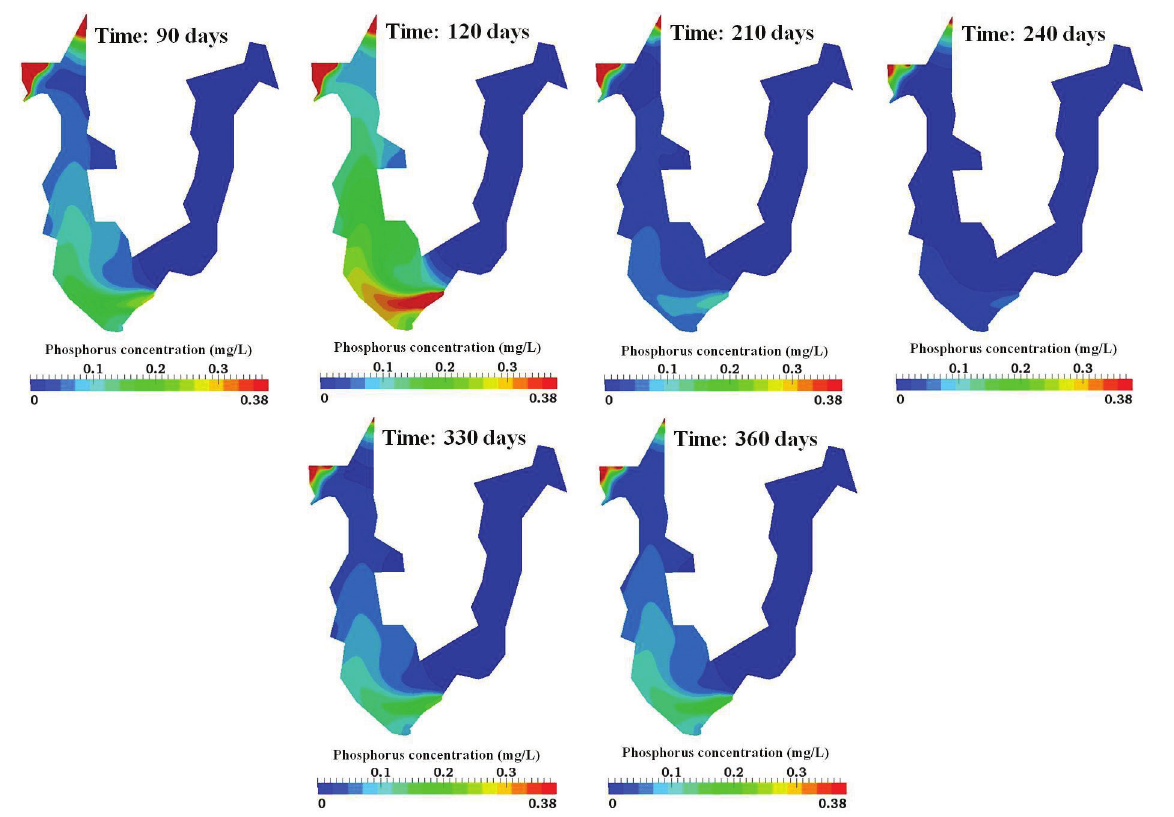
Figure 11 - Temporal evolution of the transport simulation of